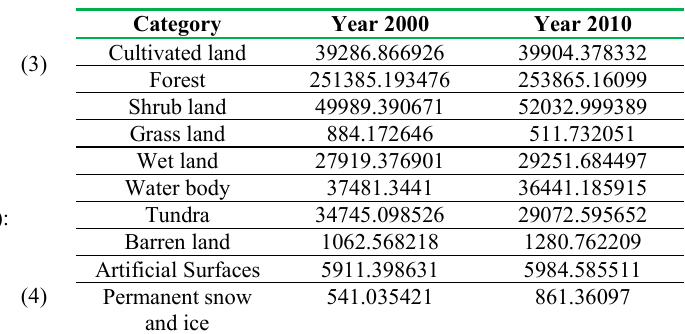
Table 3. Categories Results of the